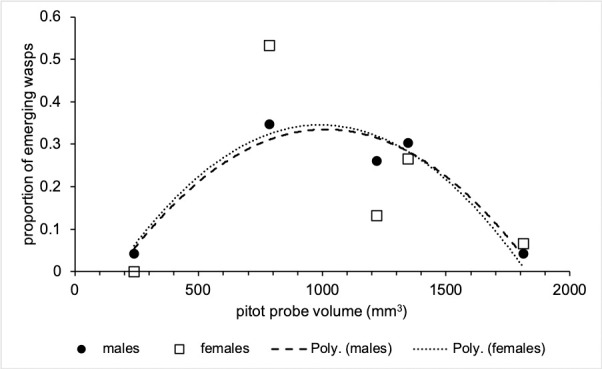
Relationship between pitot probe volume and sex of emerging live adult wasps.Second order polynomial line of best fit fitted. R2male = 0.942 (p < 0.05), R2female = 0.517 (ns).